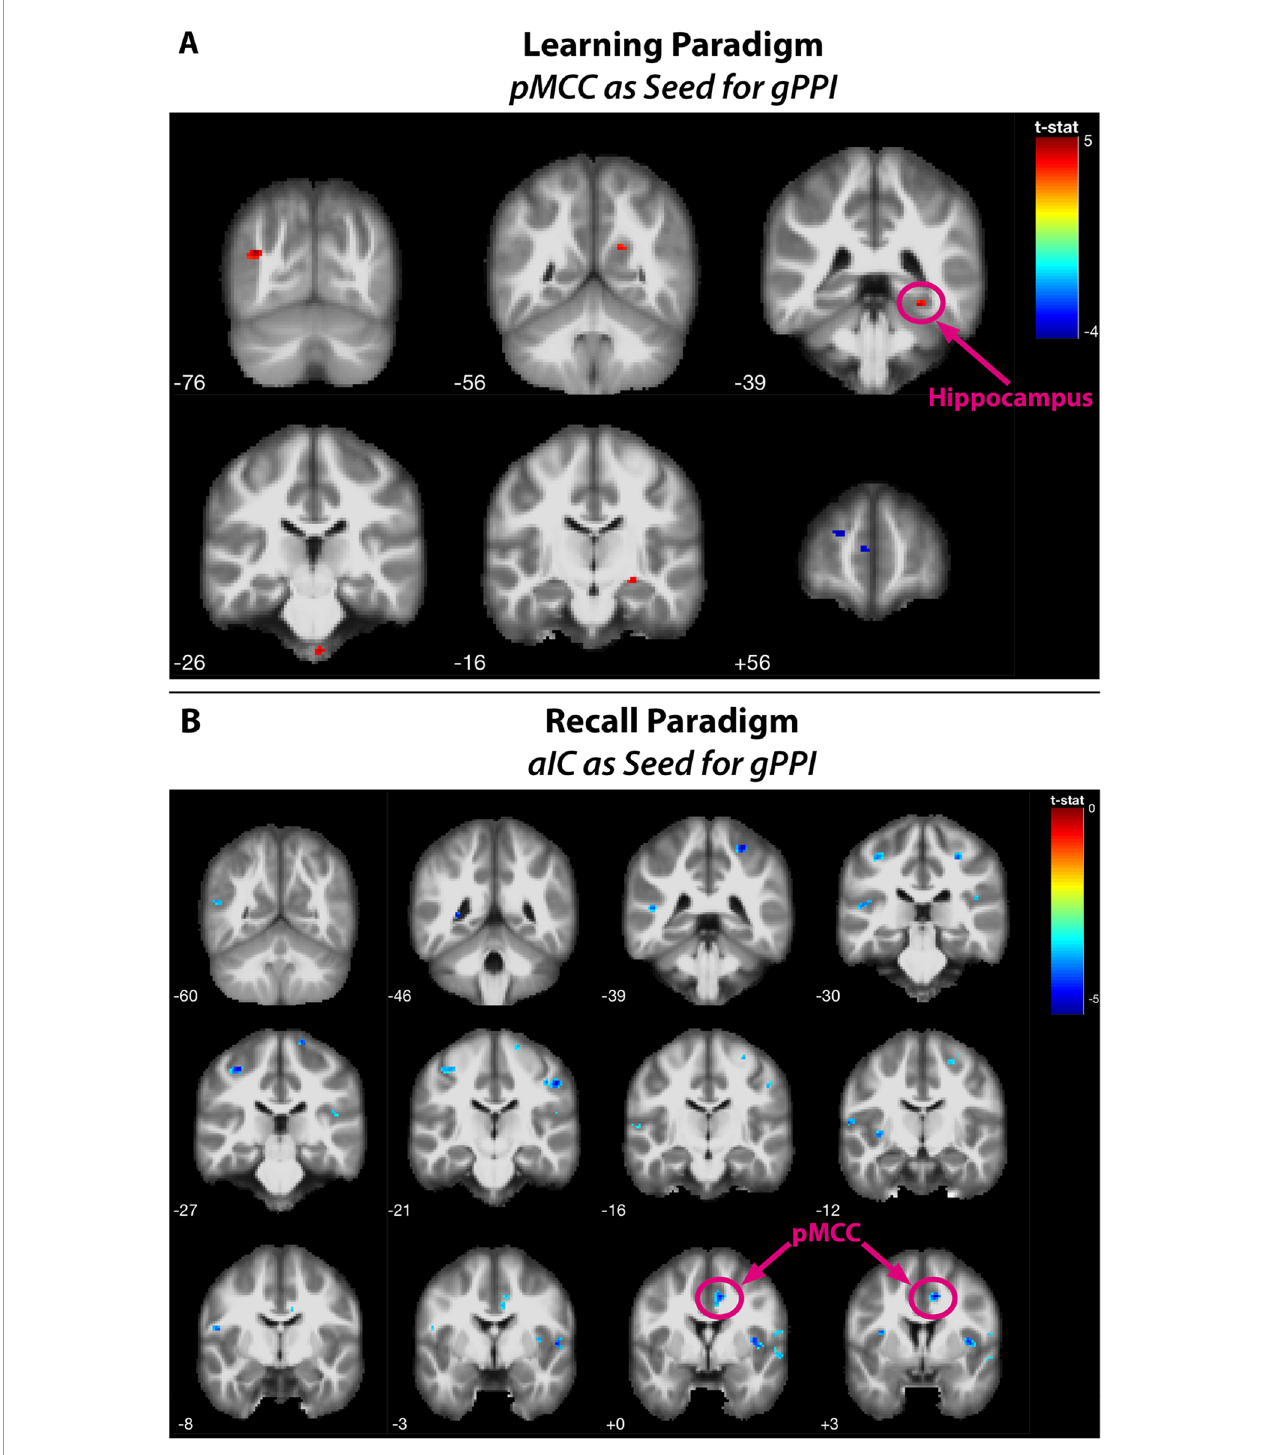
FIGURE 6 | Findings of the generalized psychophysiological interaction (gPPI) analyses. Positive and negative functional connectivities during (A) the learning paradigm [seed is a 6-mm-radius sphere around the posterior midline region (PMR) as identi fi ed by the conjunction analysis (MNI: 14/ − 32/38)] and (B) the recall paradigm [seed is a 6-mm-radius sphere around the anterior insular cortex (aIC) as identi fi ed by the conjunction analysis (MNI: 33/23/ − 6)]. Functionally connected regions were rendered on coronal slices of the anatomic MNI template, thresholded at p < 0.001 with a minimum cluster size of 20 contiguous